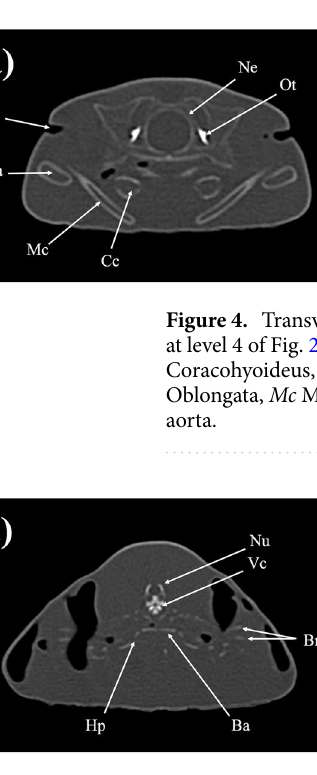
Figure 5. Transverse ( a ) CT, ( b ) MR, and ( c ) cryosection images of a banded houndshark ( Triakis scyllium ) at level 5 of Fig. 25. Aa Afferent branchial artery, Ab Adductor branchial, As Anterior cardinal sinus, Ba Basibranchial, Br Branchial rays, Ca Conus arteriosus, Cb Coracobranchialis, Ch Coracohyoideus, Co Coracomandibularis, Ds Dorsal skeletogenous septum, Ea Epaxial, Ec Epibranchial and ceratobranchial cartilage, Gf Gill filament, Hp Hypobranchial cartilage, Nu Neural arch, Vc Vertebral centrum.